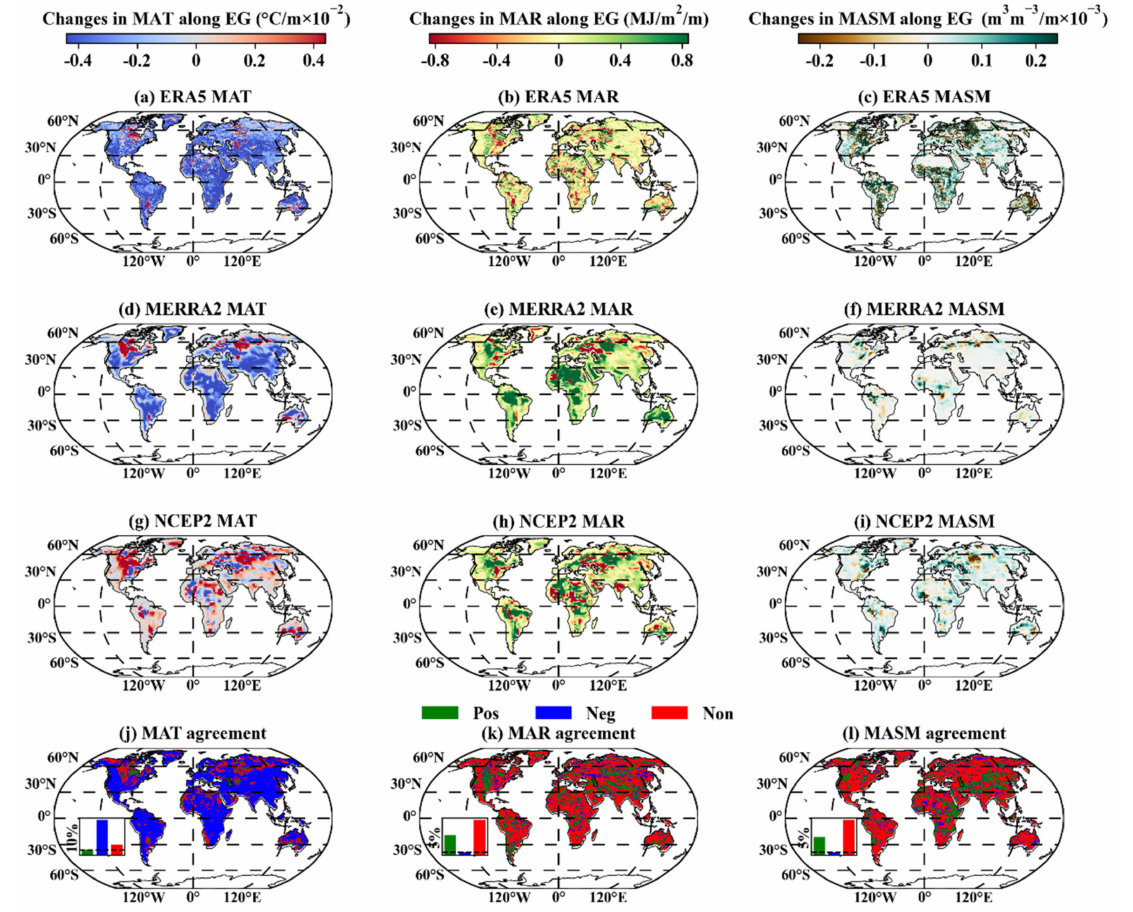
Figure 7. Spatial patterns of MAT ( a , d , g ), MAR ( b , e , h ), MASM ( c , f , i ) (derived from ERA5, MERRA2, and NCEP2) along EG and their spatial consistencies ( j , k , l ) from 2001 to 2020. The frequency of the uncertainty value is in the left of subfigures ( j , k , l